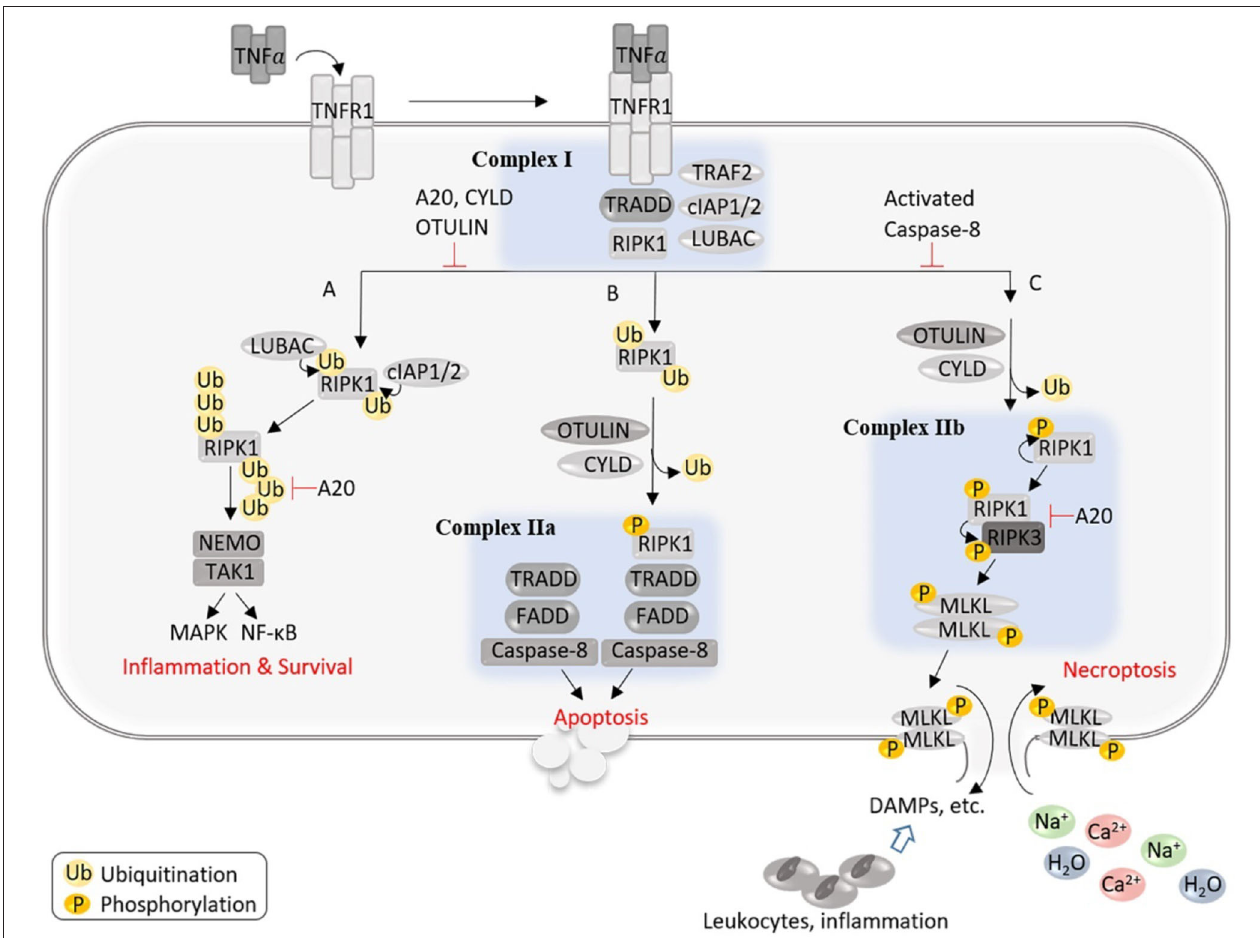
FIGURE 2 | An illustration of the potential signaling events and outcomes after the activation of TNFR1. The binding of TNF α to TNFR1 induces the formation of a membrane-bound assembly known as Complex I, which is associated with the cytoplasmic tail of TNFR1 and contains TRADD, RIPK1, TRAF2, LUBAC, and cIAP1/2, where LUBAC adds linear ubiquitin chains to RIPK1 and other proteins, whereas cIAP1/2 catalyze the addition of K63-linked polyubiquitin chains to RIPK1 and other proteins within Complex I. The ubiquitinated RIPK1 functions as a scaffold to recruit NEMO and TAK1, leading to the activation of NF κ B and MAPK pathways, respectively, and promotes cell survival and inflammation (A) . Complex I can be transformed into the secondary cytosolic Complex IIa and IIb to signal apoptosis (B) or necroptosis (C) , respectively. (B) Caspase-8 activity in Complex IIa determines downstream signaling toward an apoptotic outcome and simultaneously prevents necroptosis by cleaving RIPK1 or RIPK3. (C) In Complex IIb, the absence or inactivation of caspase-8 triggers autophosphorylation of RIPK1, which in turn binds and phosphorylates RIPK3; phosphorylated RIPK3 recruits and phosphorylates MLKL, leading to MLKL’s translocation to the plasma membrane where MLKL oligomerizes and forms pores, allowing an influx of extracellular ions and water into the cell that causes cell swelling and rupture, and the release of cellular contents triggers proinflammatory